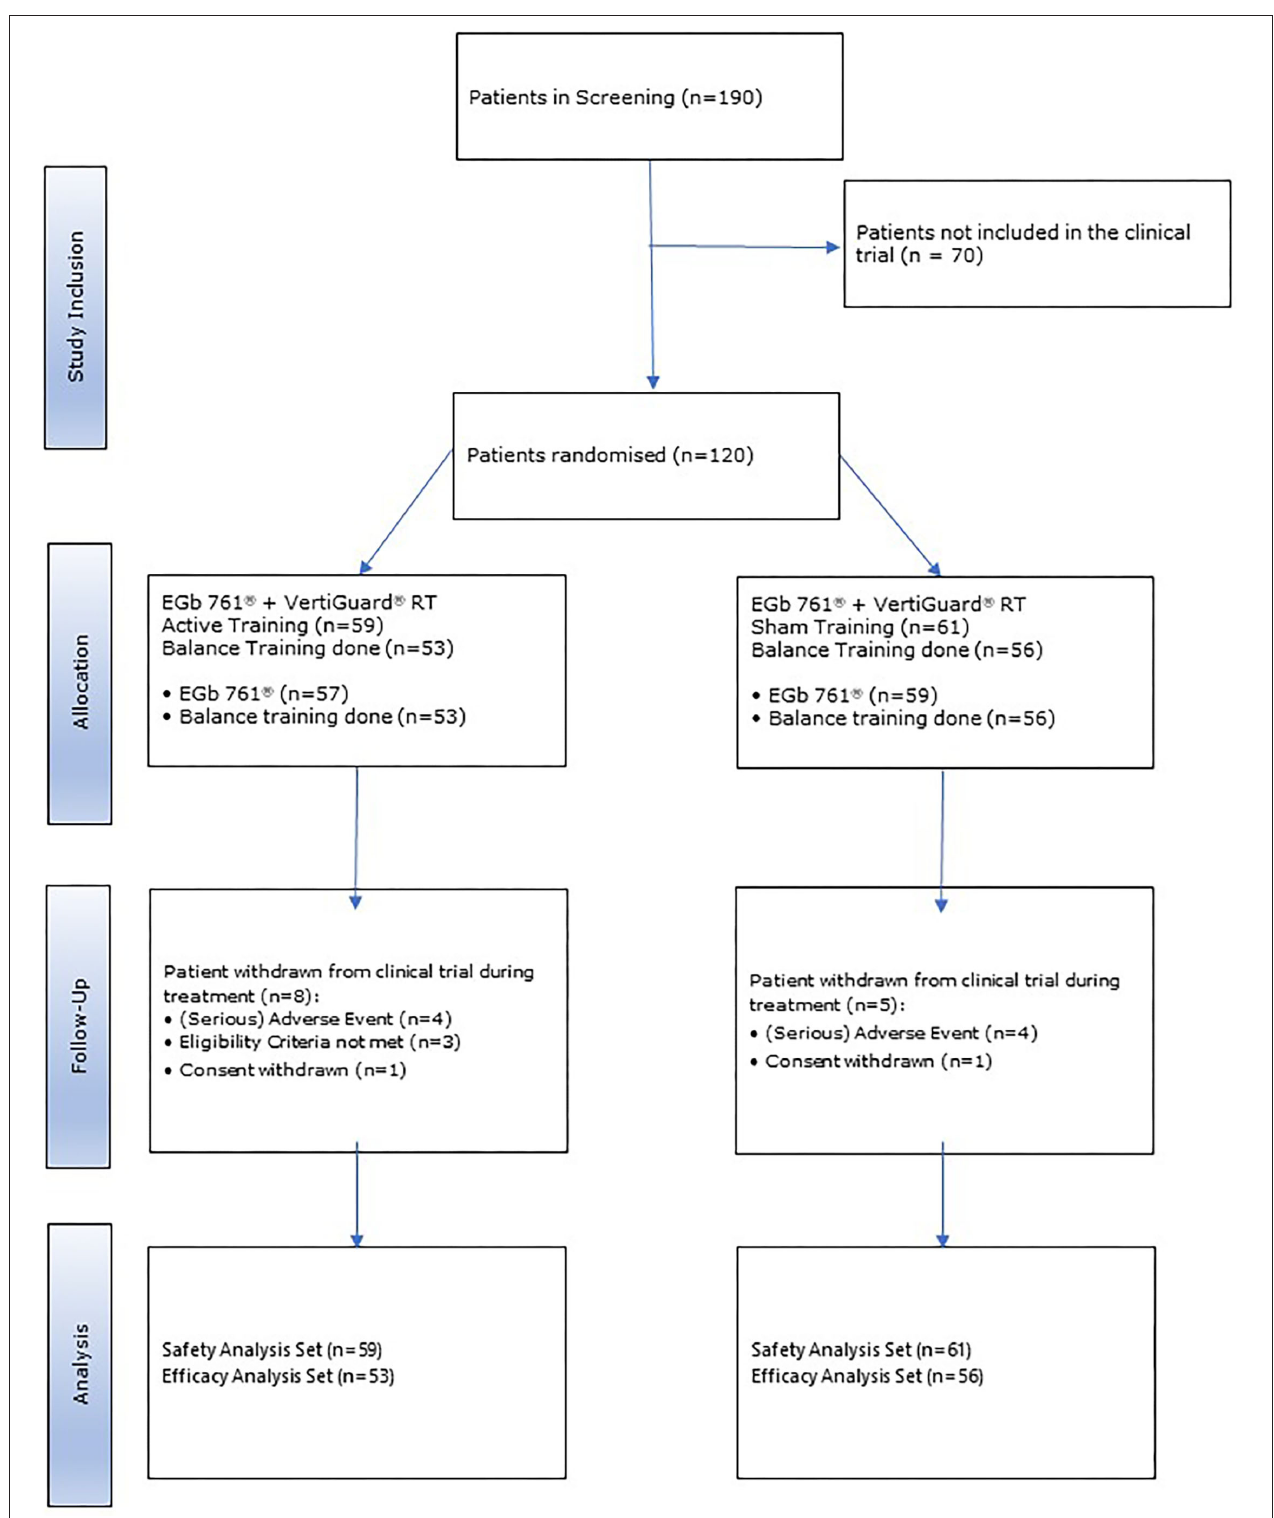
FIGURE 1 | Patient